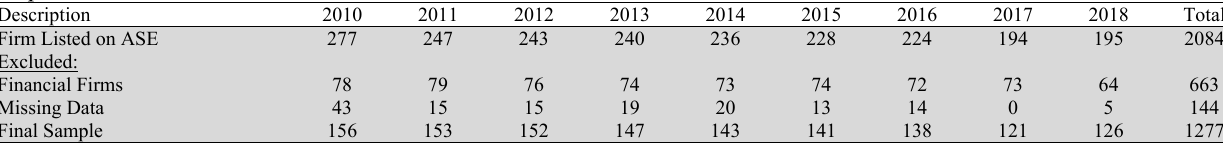
Sample selection criteria for listed firms on the ASE from 2010 to 2018 Description